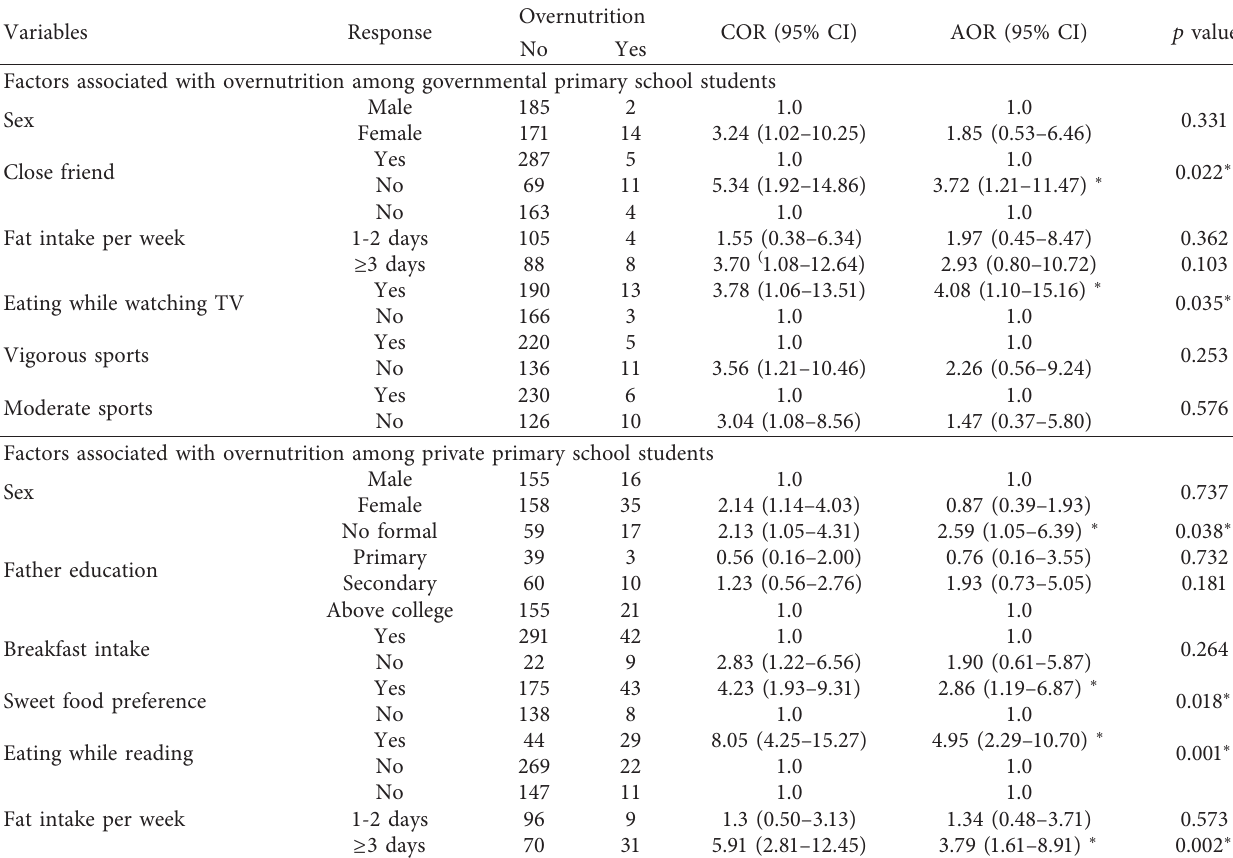
Table 5: Multivariable logistic regression of factors associated with overnutrition among governmental primary school students, 2019 ( n � 736).